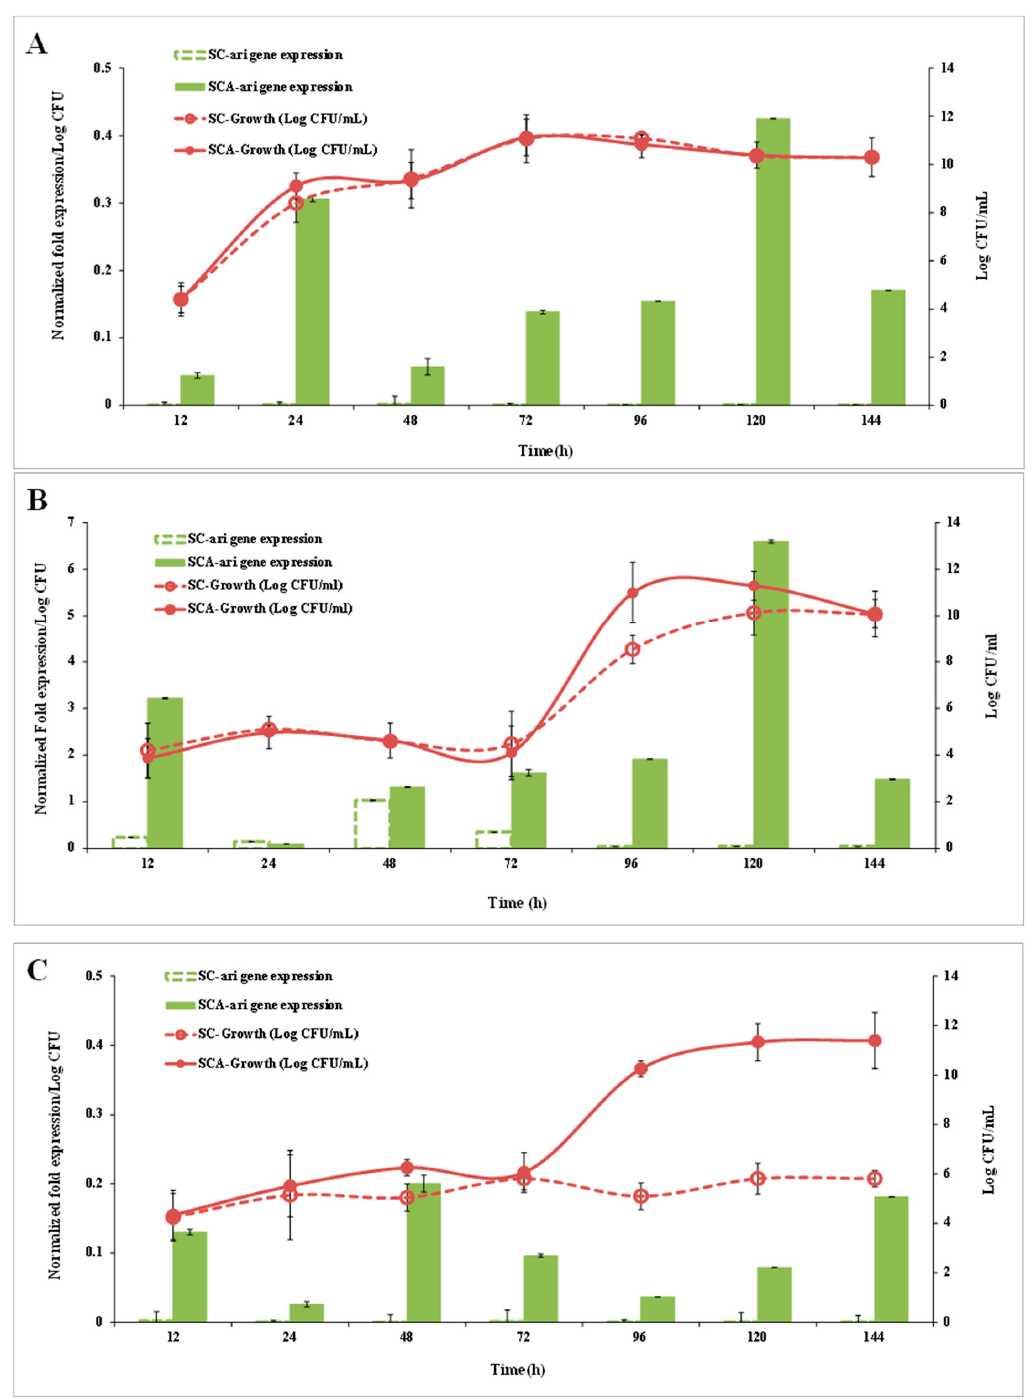
Figure 6. Ari gene expression (bar chart) and cell growth (graph) of SCA (filled symbol) and SC (open symbol) on the YPD medium ( A ), YPD + 20 mM furfural ( B ) and YPD + 60 mM HMF ( C ). SC ( S. cerevisiae ) and SCA ( S. cerevisiae with ari1 gene overexpression).